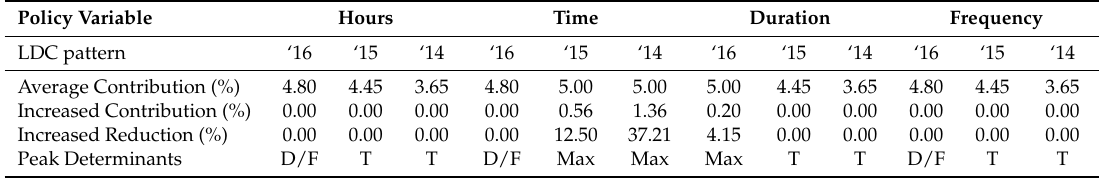
Table 5. Summary of initial sensitivity simulation results with relaxed